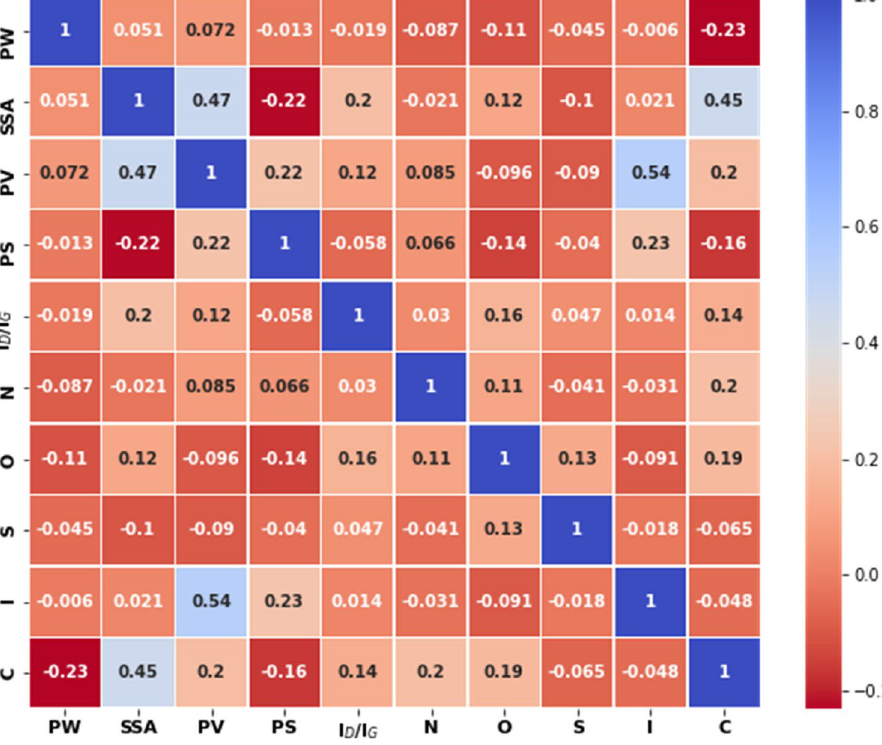
Figure 3. Spearman’s correlation between the physicochemical characteristics of the carbon electrodes of supercapacitors in the considered